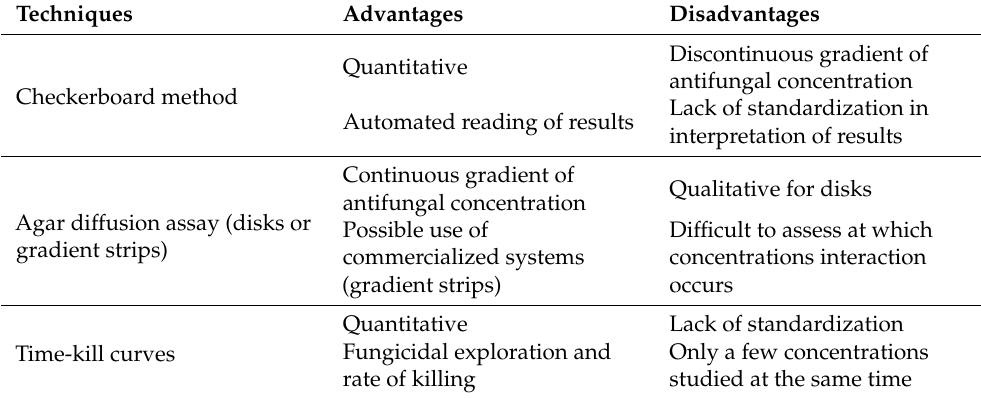
Table 1. Summary of the advantages and disadvantages of the different methods used to study antifungal combinations in vitro.